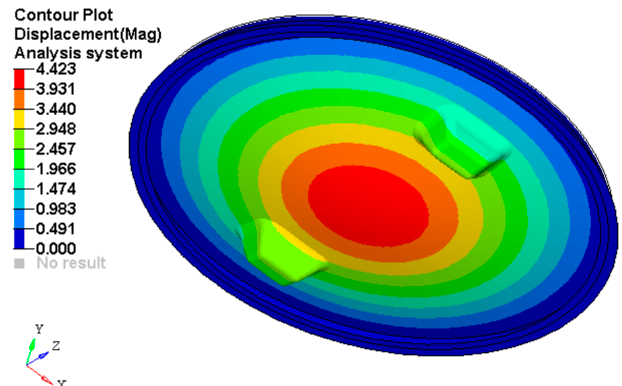
Figure 13. Plot of the displacements on the manhole cover ( F = 2 kN).